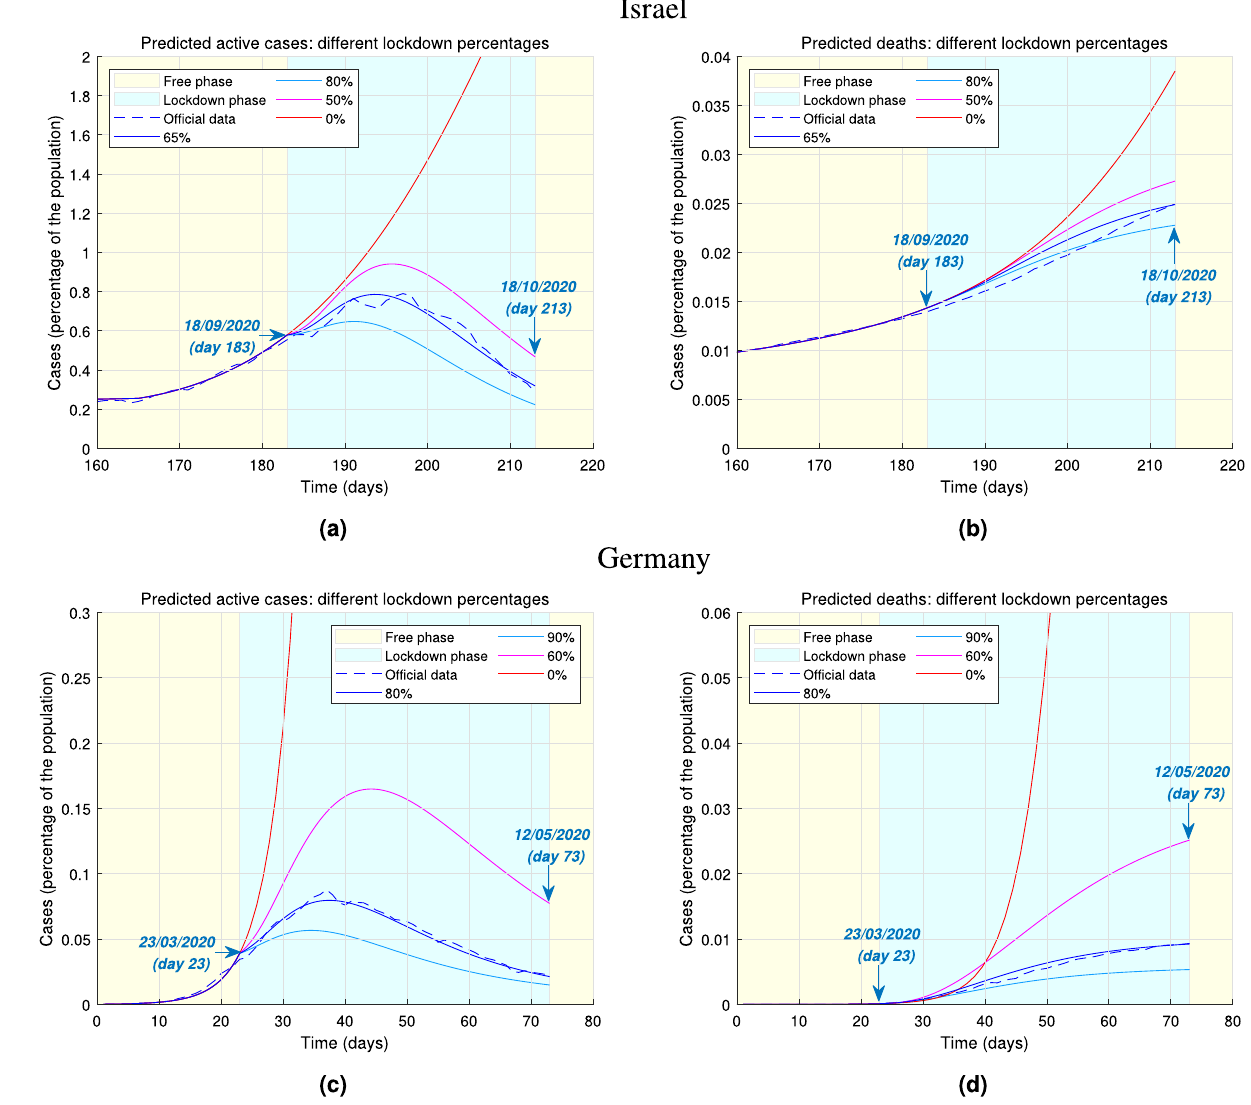
Figure 2. Predicted epidemic evolution under different lockdown stringency. Evolution of the COVID-19 epidemic in Israel and Germany as predicted by our model, based on available government data. ( a ) Actual evolution and model predictions of the active cases of infections in Israel by lockdown stringency. ( b ) Actual evolution and model predictions of the deaths in Israel by lockdown stringency. ( c ) Actual evolution and model predictions of the active cases of infections in Germany by lockdown stringency. ( d ) Actual evolution and model predictions of the deaths in Germany by lockdown